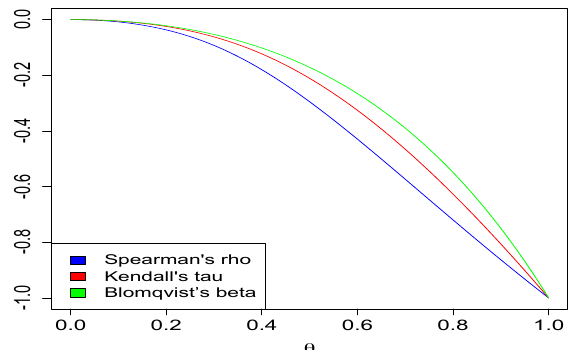
Figure 5. Graph of Spearman’s rho, Kendall’s tau and Blomqvist’s